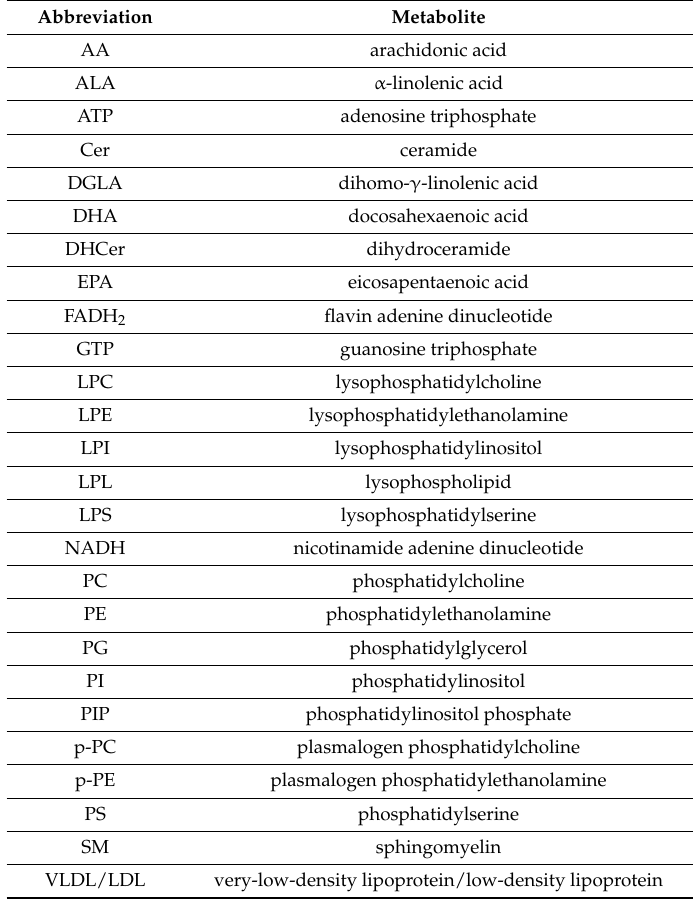
Table 1. Metabolite abbreviations. Other abbreviations are listed at the end of the